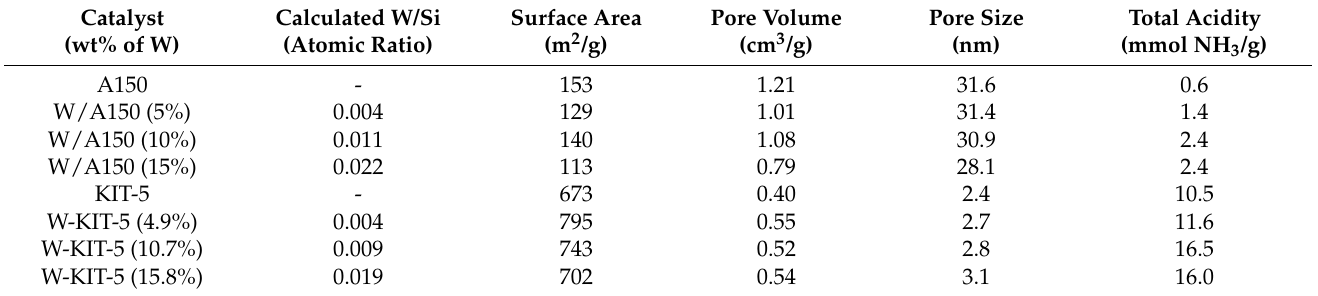
Table 1. Chemical characteristics, textural properties, and acidity of the synthesized catalysts.